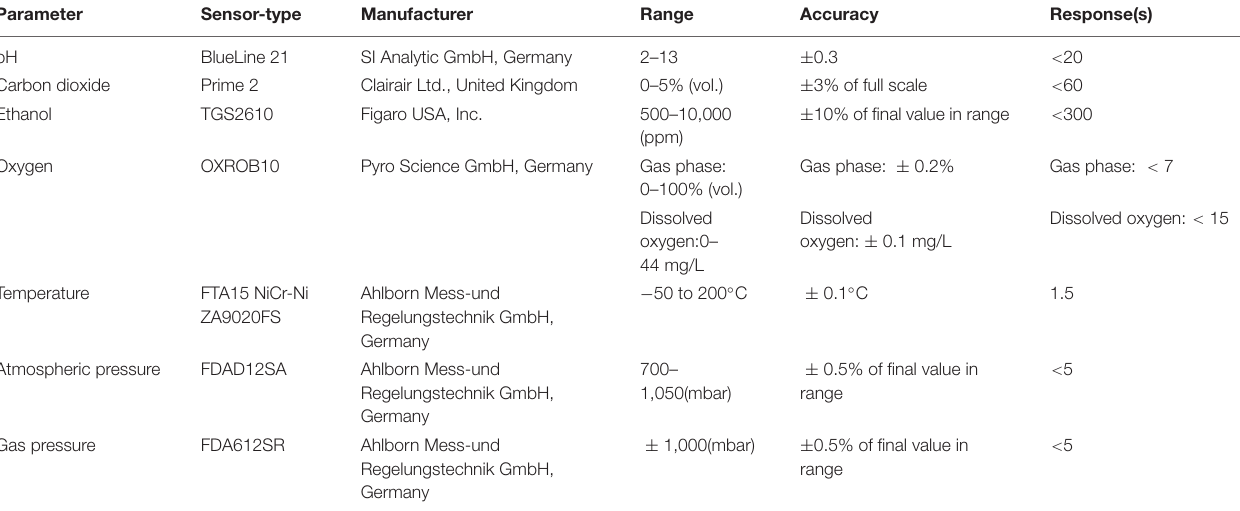
FIGURE 1 | The multi-parameter measurement system devised for selecting microbes used as silage inoculant, based on the characteristics of lactic acid bacterial (LAB) fermentation and the theory of optimal control. TABLE 1 | Technical information of the pH, CO 2 , ethanol (EtOH), O 2 , temperature, and pressure sensors